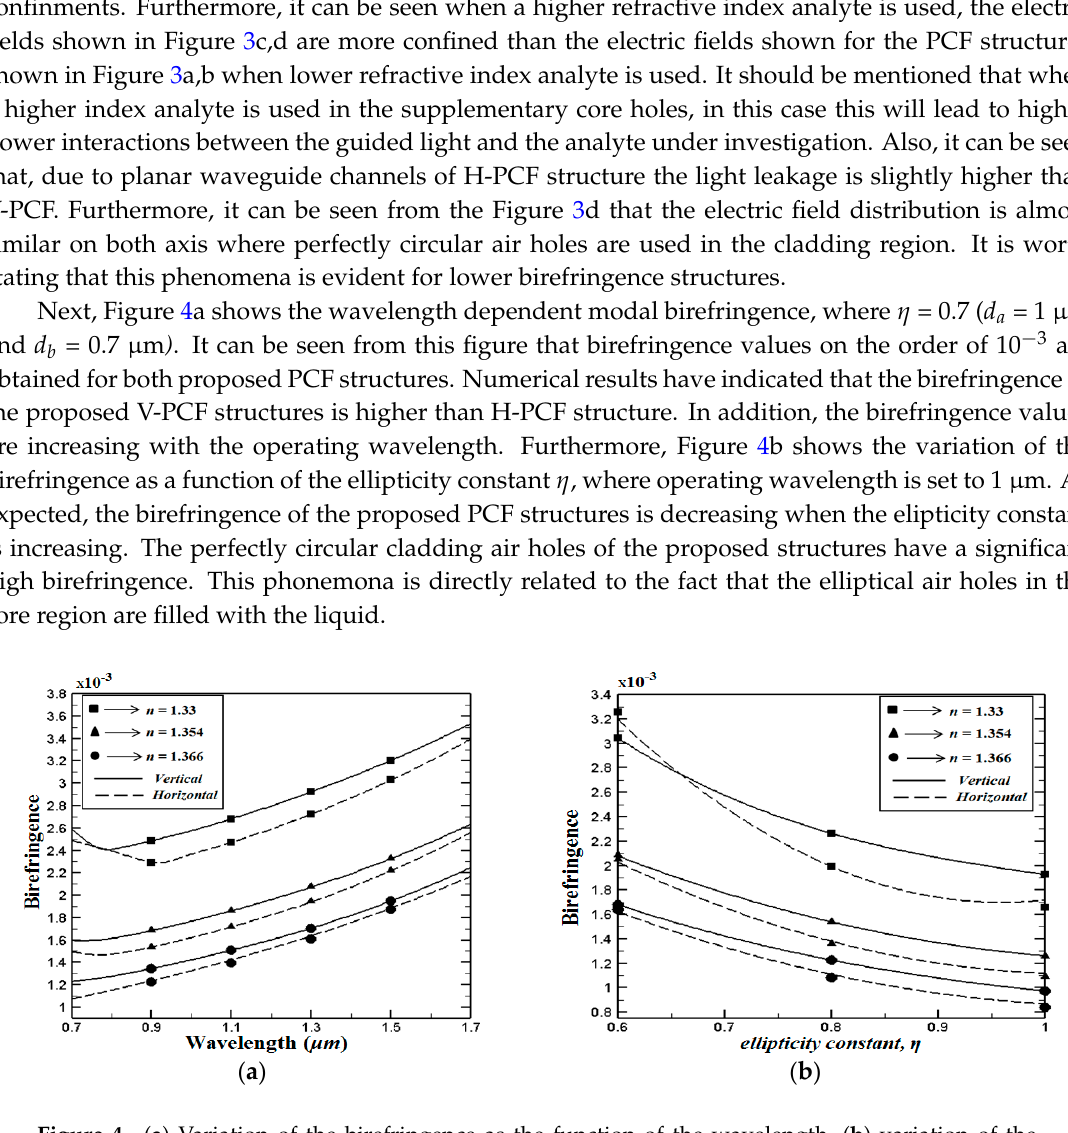
Figure 4. ( a ) Variation of the birefringence as the function of the wavelength, ( b ) variation of the birefringence as a function of the ellipticity constant η , where the operating wavelength is fixed to 1 µm.